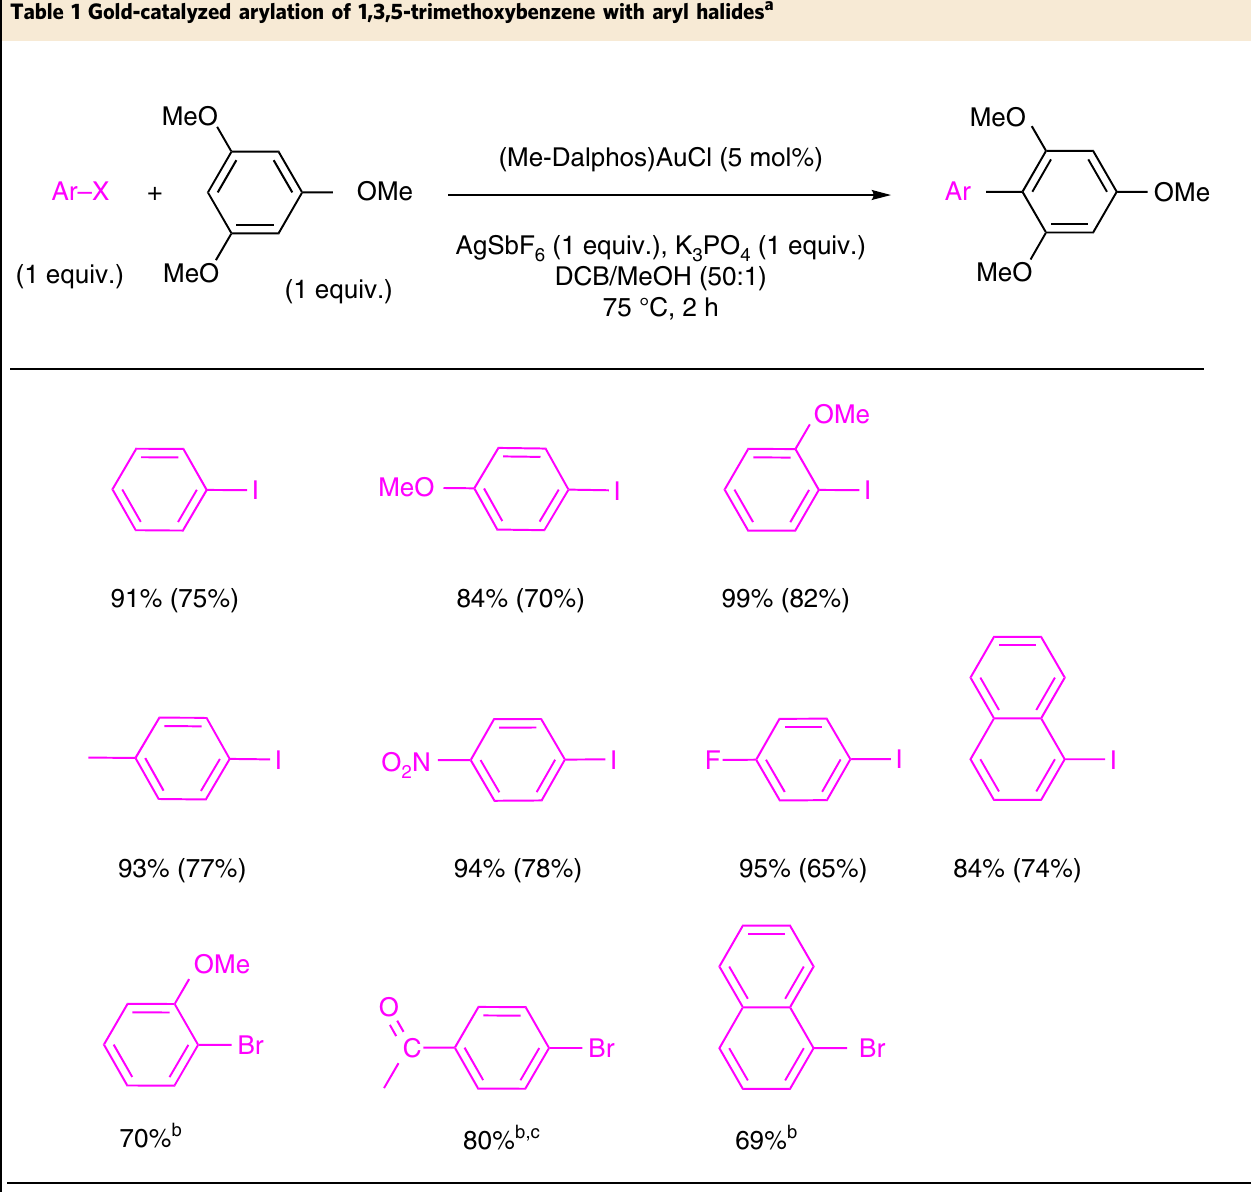
Table 1 Gold-catalyzed arylation of 1,3,5-trimethoxybenzene with aryl halides